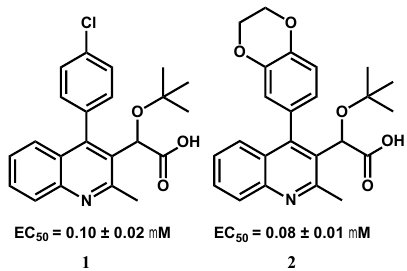
Figure 2. Quinolines utilized for HIV-1 IN inhibition whose EC 50 values were previously evaluated utilizing the multimerization assay.